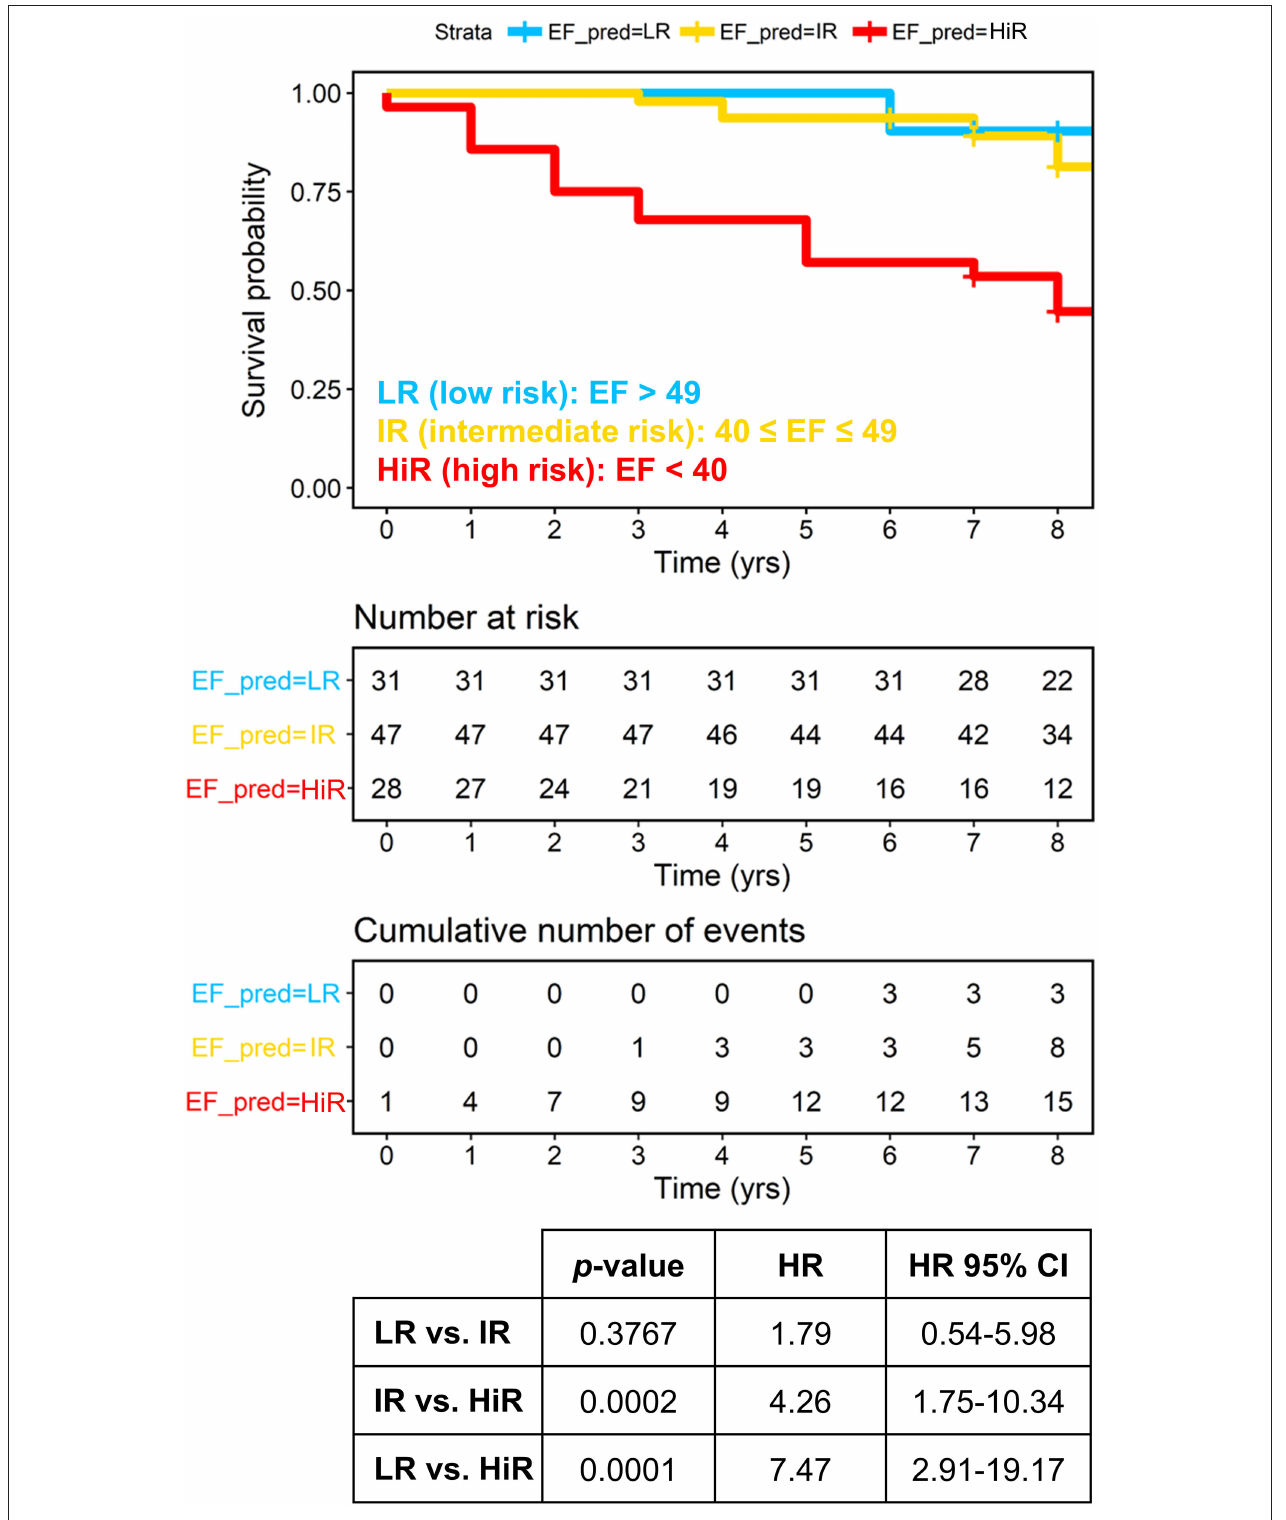
FIGURE 3 | Overall patients with HF, plotting actual survival over time (measured in years) according to risk estimated based on ejection fraction (Kaplan-Meier curves). High-risk (red) group is significantly clustered with respect to both intermediate (yellow) and low (blue) risk groups with HR of 4.26 and 7.47,